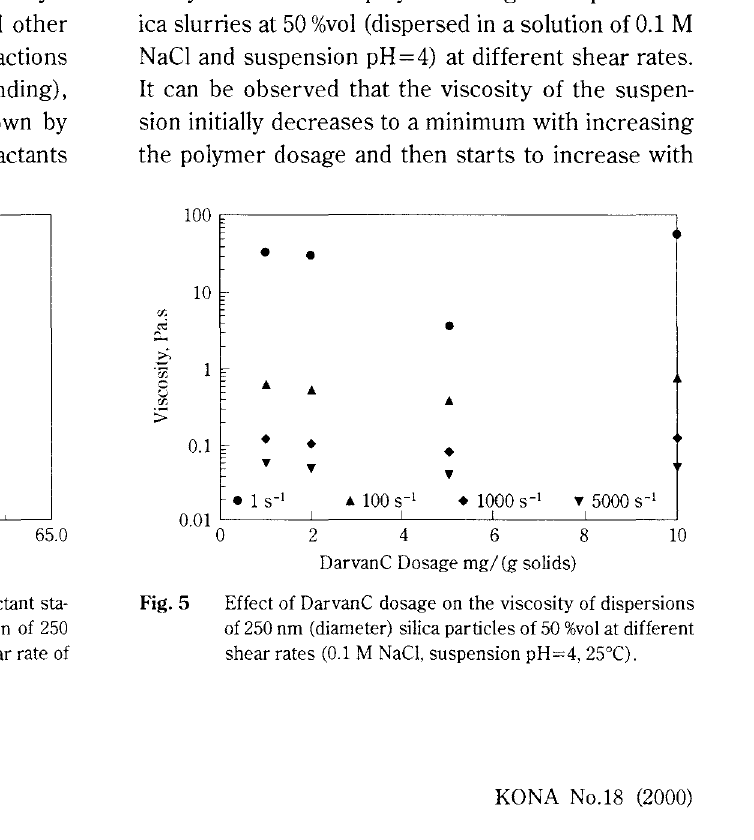
Effect of temperature on the viscosity of a surfactant sta bilized (0.1 M NaCI, 280 mM C 12 TAB) dispersion of 250 nm (diameter) silica particles of 50 %vol at a shear rate of 50 s- 1 (suspension pH=4).